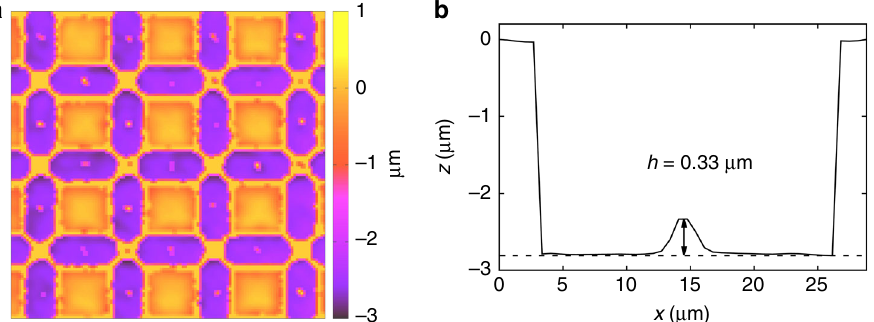
Fig. 5 Comparison between experiments, numerics and theoretical predictions. Panels show experimental results (bullets) and numerical results (diamonds) compared to theoretical predictions (solid lines). a Vertex statistics n z charge q . Dark blue: q = − 4; light blue: q = − 2; black: q = 0; pink: q = + 2; red: q = + 4. All the non-ice-rule vertices are suppressed except q = − 2 monopoles, which increase with η as the availability of z = 3 vertices for charge transfer increases. b Vertex statistics n z q = − 3; light blue: q = − 1; pink: q = + 1; red: q = + 3. Only ice rule vertices are present ( q = ±1), but there is an excess density of positive q = + 1 charges in order to screen the charge transfer from the z = 4 sector. As η → ∞ , the z = 4 sector disappears and thus n z n ¼ n ¼ 1 = 2, as also found in kagome ice 45 . c Net density of charge q z 3 ; q ¼ 1 z 3 ; q ¼(cid:2) 1 d Charge screening Q NN of q = − 2 monopoles (blue) and “ screening ” of q = 0 ice rule vertices (black) on z = 4 vertices vs η . At large decimation we fi nd sparse z = 4 vertices embedded in a background of z = 3 vertices. The z = 3 vertices have an average charge of 〈 Q 3 〉 = + 0.15, but the charge is much larger ( 〈 Q 3 〉 = + 1.25) in the nearest neighborhood of q = − 2 monopoles. This indicates that the disordered sea of z = 3 charges screens the monopoles